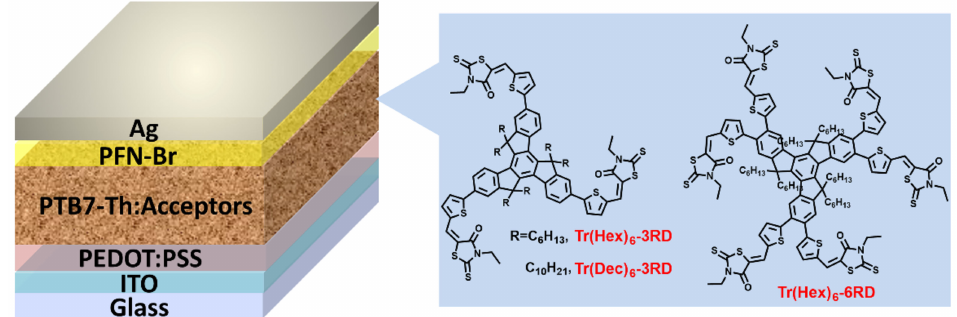
Figure 1. Device and chemical structures of truxene-centered